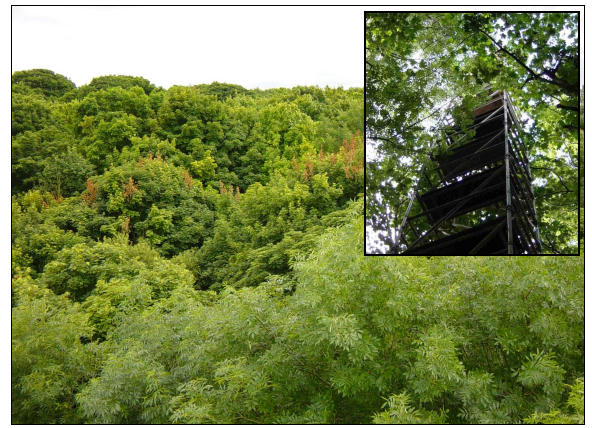
Fig. 2. South-facing aspect from the flux tower, with an insert look- ing up the flux tower from ground level. Sources: CEH and